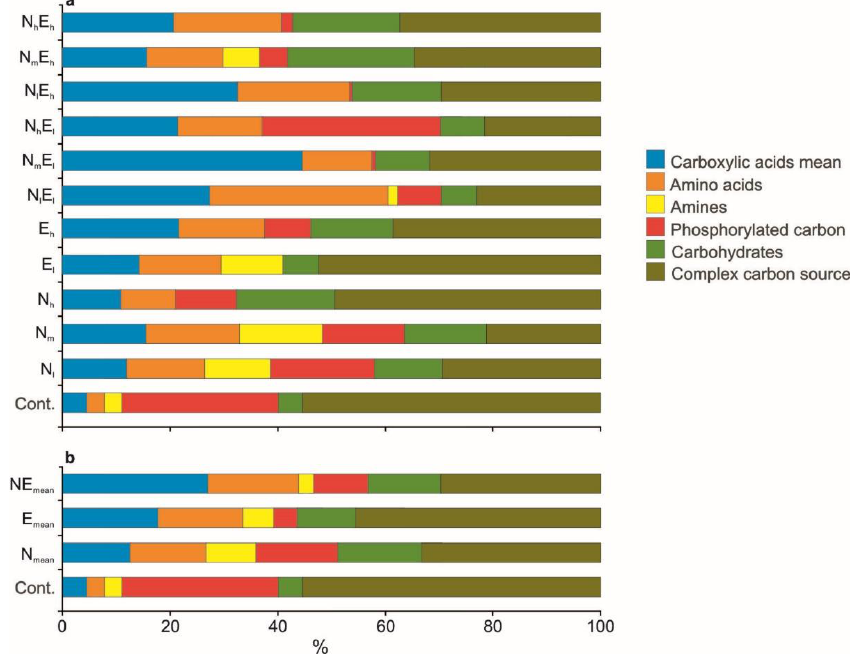
Figure 5. Percentage share of respiration rate (V max ) of different carbon sources by the gut microbiota of Daphnia ( a ) from the control variant (Cont.) and from variants of a single or combined low, medium and high density of polystyrene NPs (N l = 10 3 , N m = 10 6 , and N h = 10 9 particles L − 1 , respectively) and low and high concentration of enrofloxacin (E l = 10 and E h = 100 ng L − 1 , respectively), and ( b ) from the control variant (Cont.) and from variants of a single or combined mean density of polystyrene NPs (N mean for the combined data from N l , N m, and N h ) and the mean concentration of enrofloxacin (E mean for the combined data from E l and E h ).